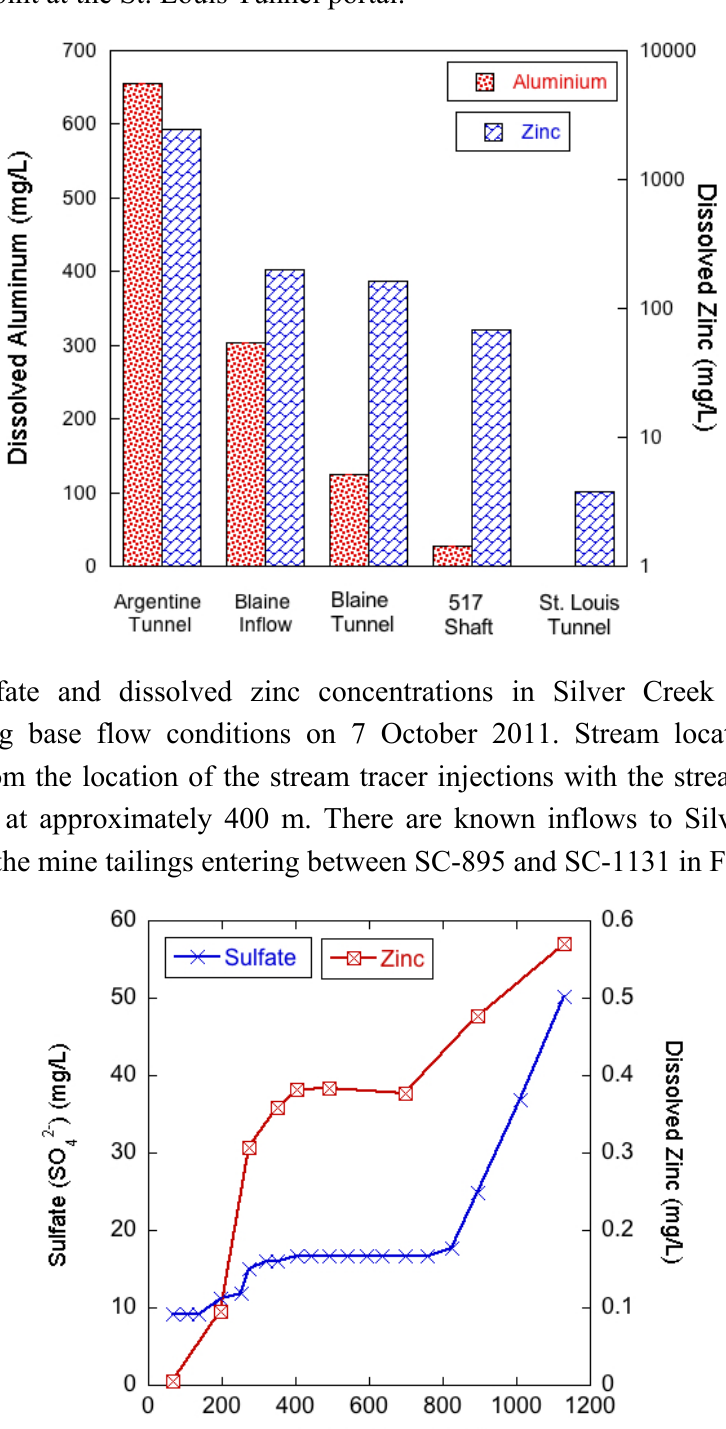
Figure 3. Dissolved zinc and total dissolved aluminum concentrations in mine workings. The mine workings are listed from left to right in the direction of hydrologic flow towards the discharge point at the St. Louis Tunnel portal.